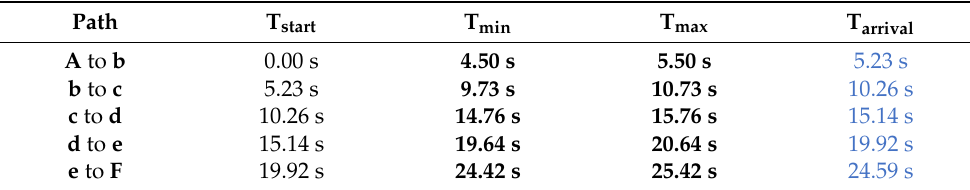
Table 1. The actual numerical time data for each waypoint, including T start , T min , T max , and the actual arrival time T arrival for the normal case. All five T arrival resulted in arriving inside the time-window without any issue. Each start time was calculated after the T arrival data were retrieved and did not consider computational delays.